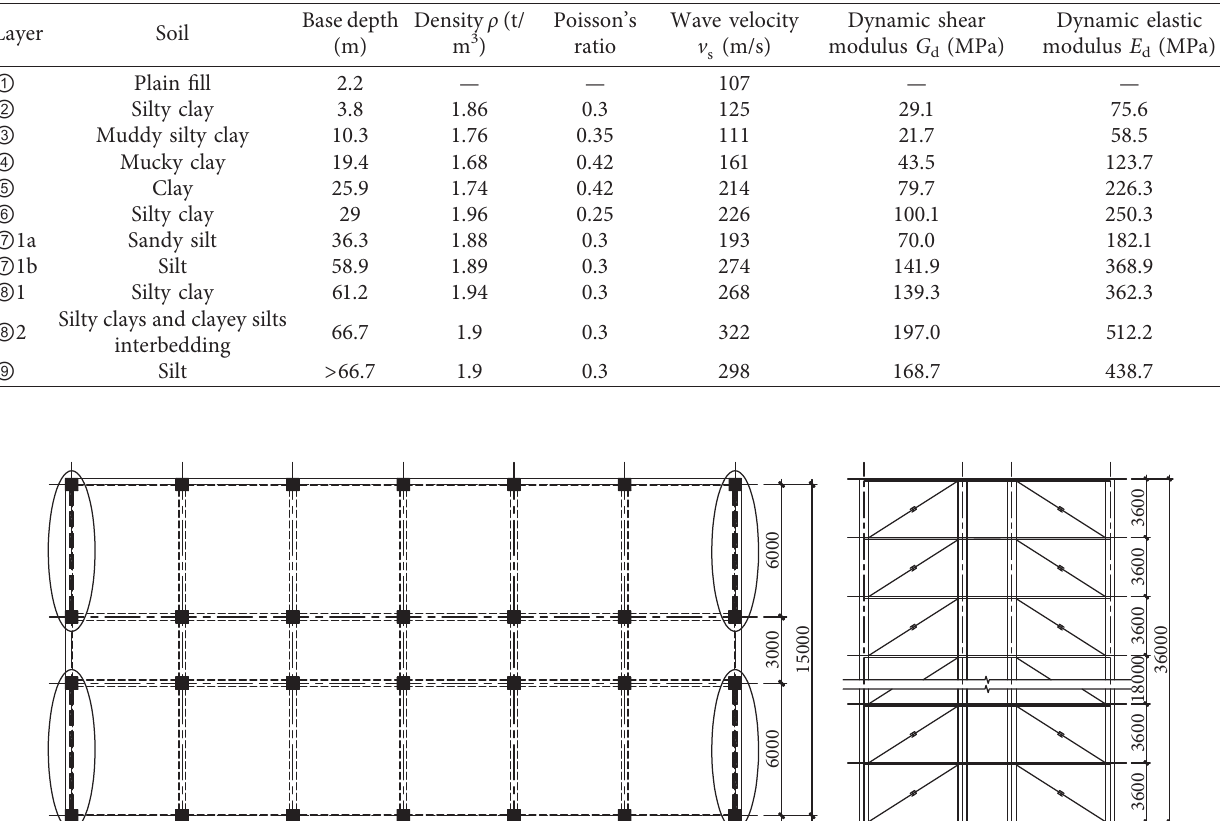
Figure 1: Standard floor plane of the frame structure (unit: m). Table 1: Physical and mechanical properties of the soil.